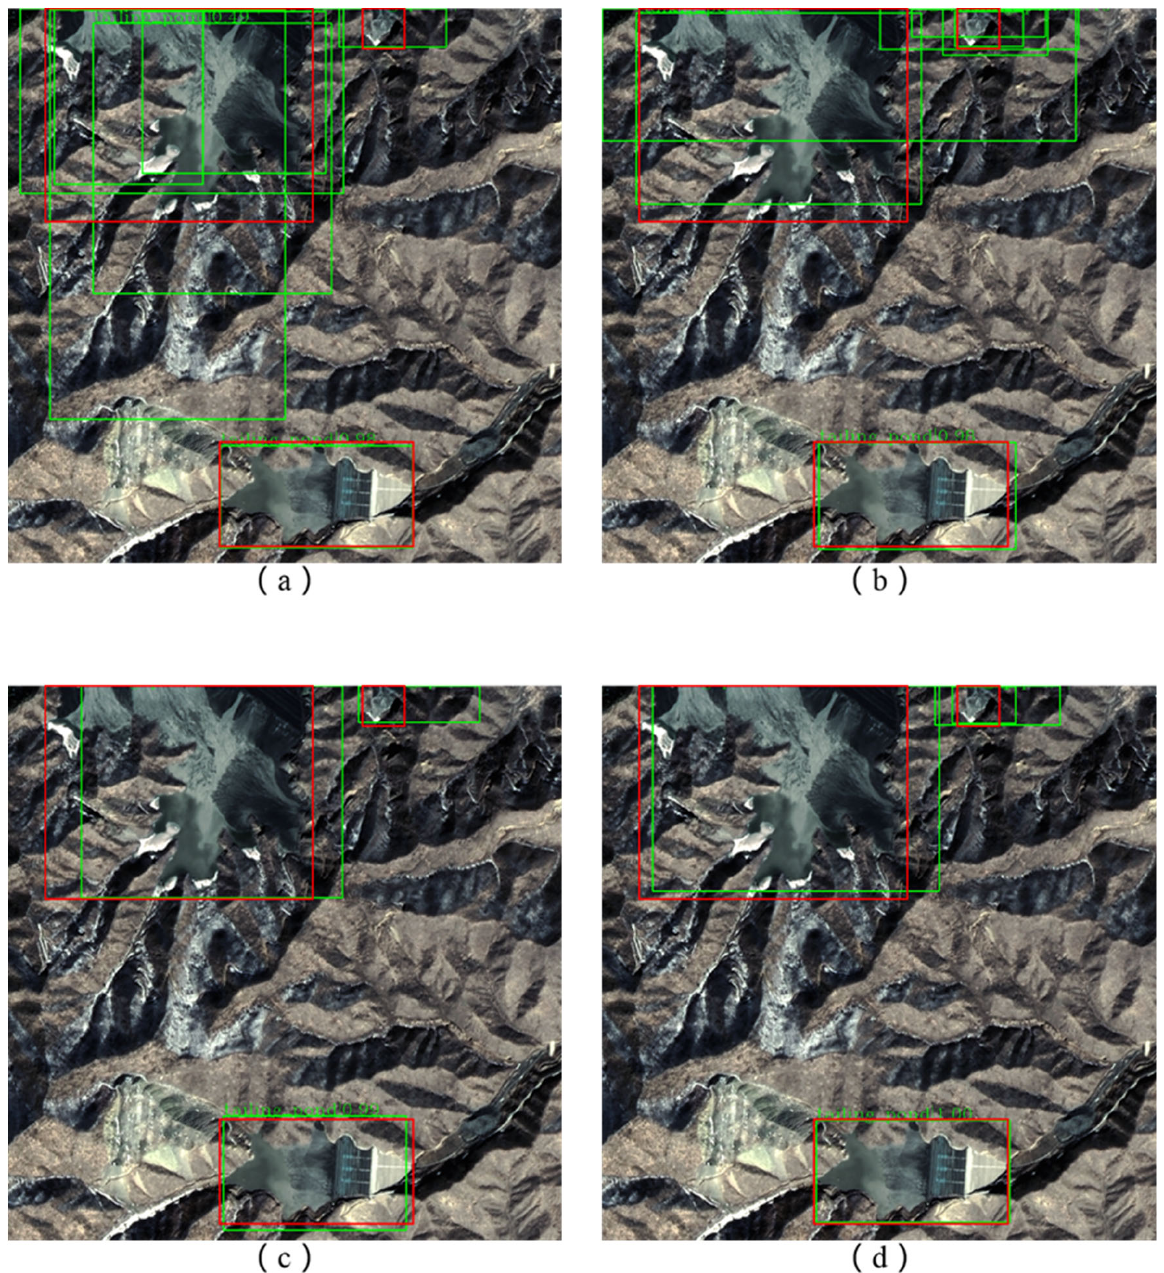
Figure 11. Improvement in mistaken detections and detection accuracy. ( a ) prediction result of the Bands_3 model, ( b ) prediction result of the Bands_4 model, ( c ) prediction result of the Bands_4_sub model, ( d ) prediction result of the Bands_4_sub_SAMB model, the red bounding box represents the GT of the tailings pond and the green bounding box represents the PT of the tailings pond.